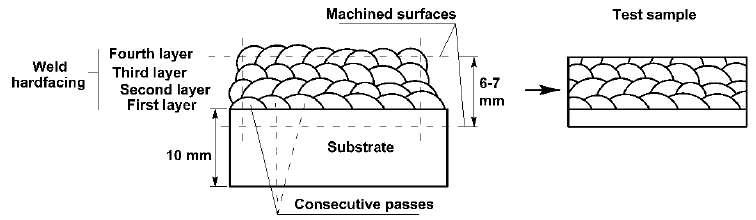
Figure 3. Scheme of hardfacing and mechanical processing to prepare the sample (the cross-section of the sample is shown).